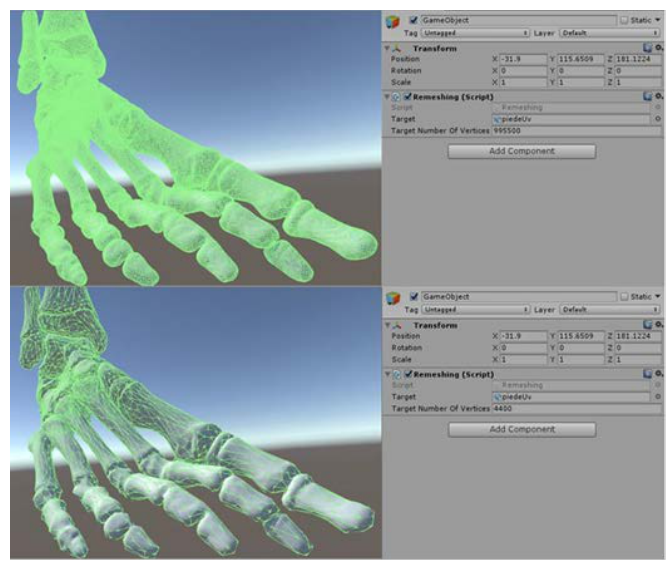
Figure 7. Foot skeleton model.